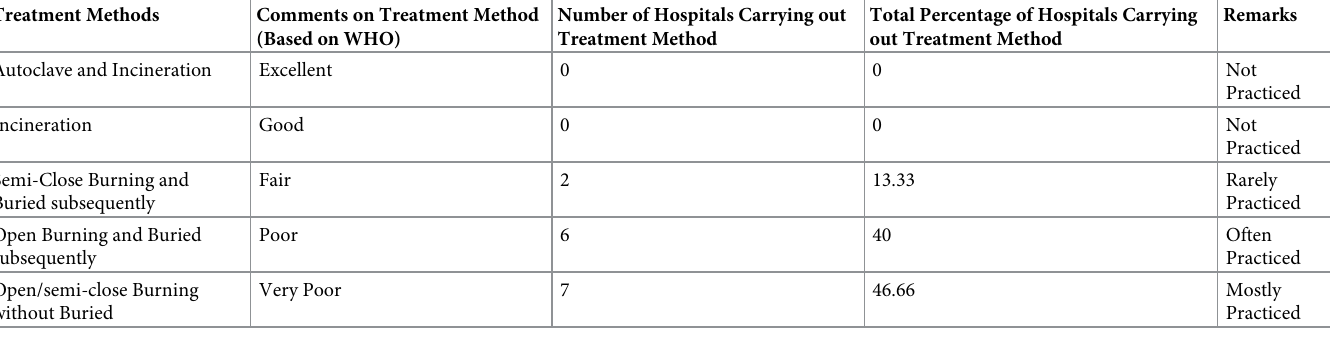
Table 4. Treatment methods for syringes and sharps disposal in the studied health complexes.